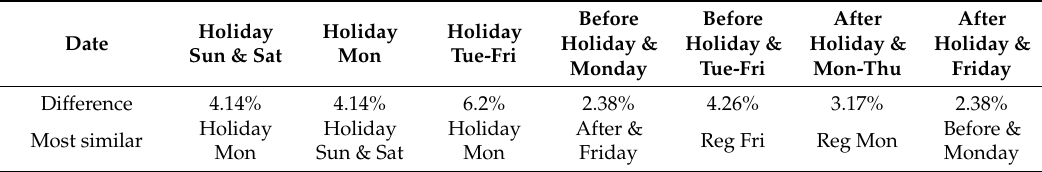
Figure 13. ( a ) Coefficient profiles for days before a holiday with regular Mondays and Wednesday as references. ( b ) Coefficient profiles for days after a holiday with regular Fridays and Wednesday as references. Table 10. Differences between special days type 1 and 2.